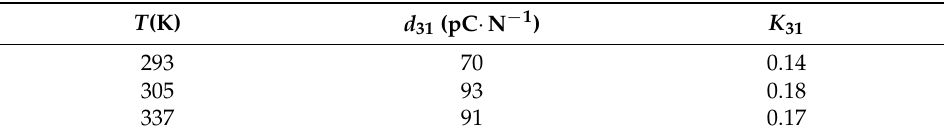
Figure 11. ( a ) Temperature dependence of the pyroelectric coefficient p and spontaneous polarization P s of the [001] pc oriented BCTZ3 single crystal; and ( b ) resonance curves for the length thickness extensional mode measured at 337K for [001] pc oriented BCTZ3 single crystal. The plot shows a frequency dependent sweep of the conductance G and the susceptance B, which are the real and imaginary components of the admittance, respectively. Table 6. Piezoelectric constants d 31 and electromechanical coupling factors k 31 calculated at three selected temperatures for BCTZ3 crystal elongated bar oriented along pseudo-cubic [001] pc direction.